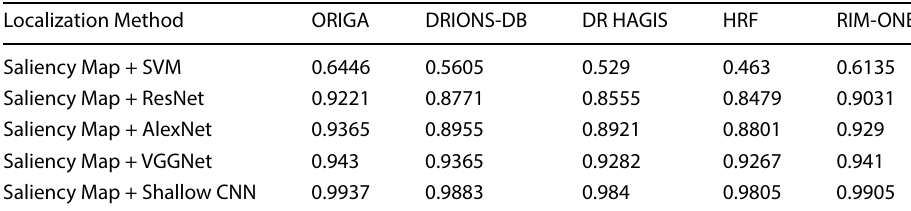
Fig. 4 A saliency map-based localization incorporating vari- ous methods including SVM, AlexNet, ResNet, VGGNet, and Shallow CNN. The extracted region of interest (ROI) with the saliency map’s ensemble and shallow CNN is considered for glaucoma